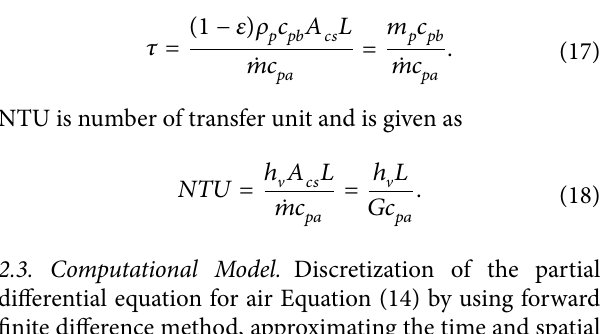
Figure 6: Schematic diagram showing the heat transfer process occurring within packed bed rocks of